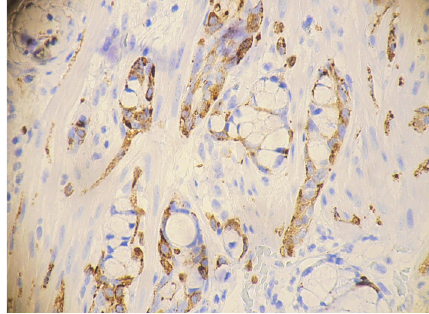
Figure 2: Goblet cell carcinoid of the appendix. The tumor cells show positivity of synaptophysin.